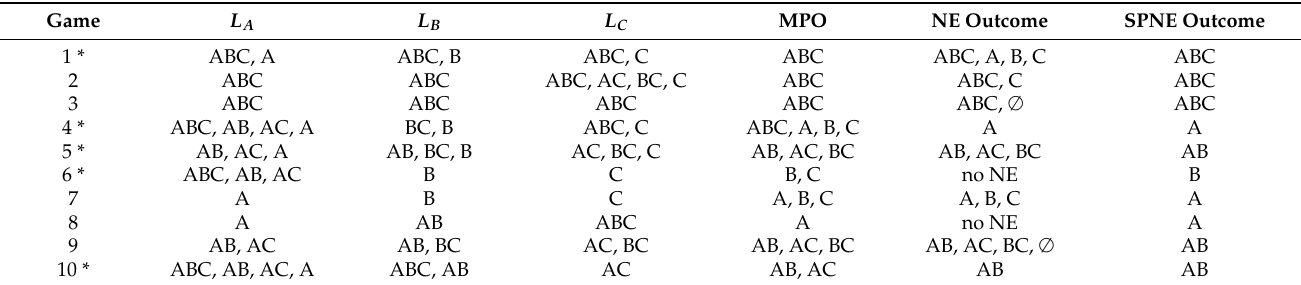
Table 1. Lists, maximum-payoff outcome, Nash equilibrium outcome, subgame-perfect Nash equilibrium outcome, games with * are implemented only in Sessions 2 and 3.